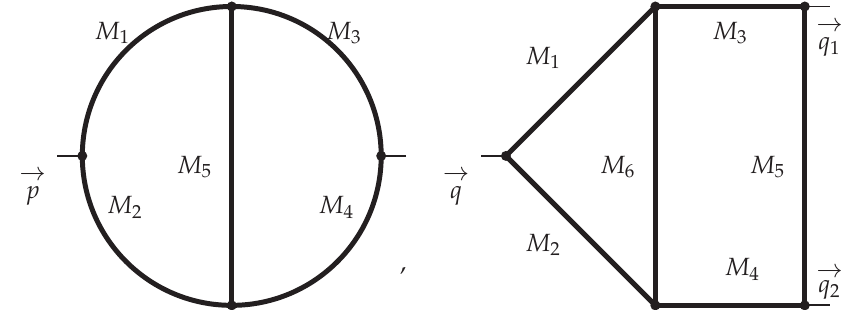
Figure 4. Two-loop two-point diagram I ( M 1 , M 2 , M 3 , M 4 , M 5 ) and three-point diagram P ( M 1 , M 2 , M 3 , M 4 , M 5 , M 6 ) with q 2